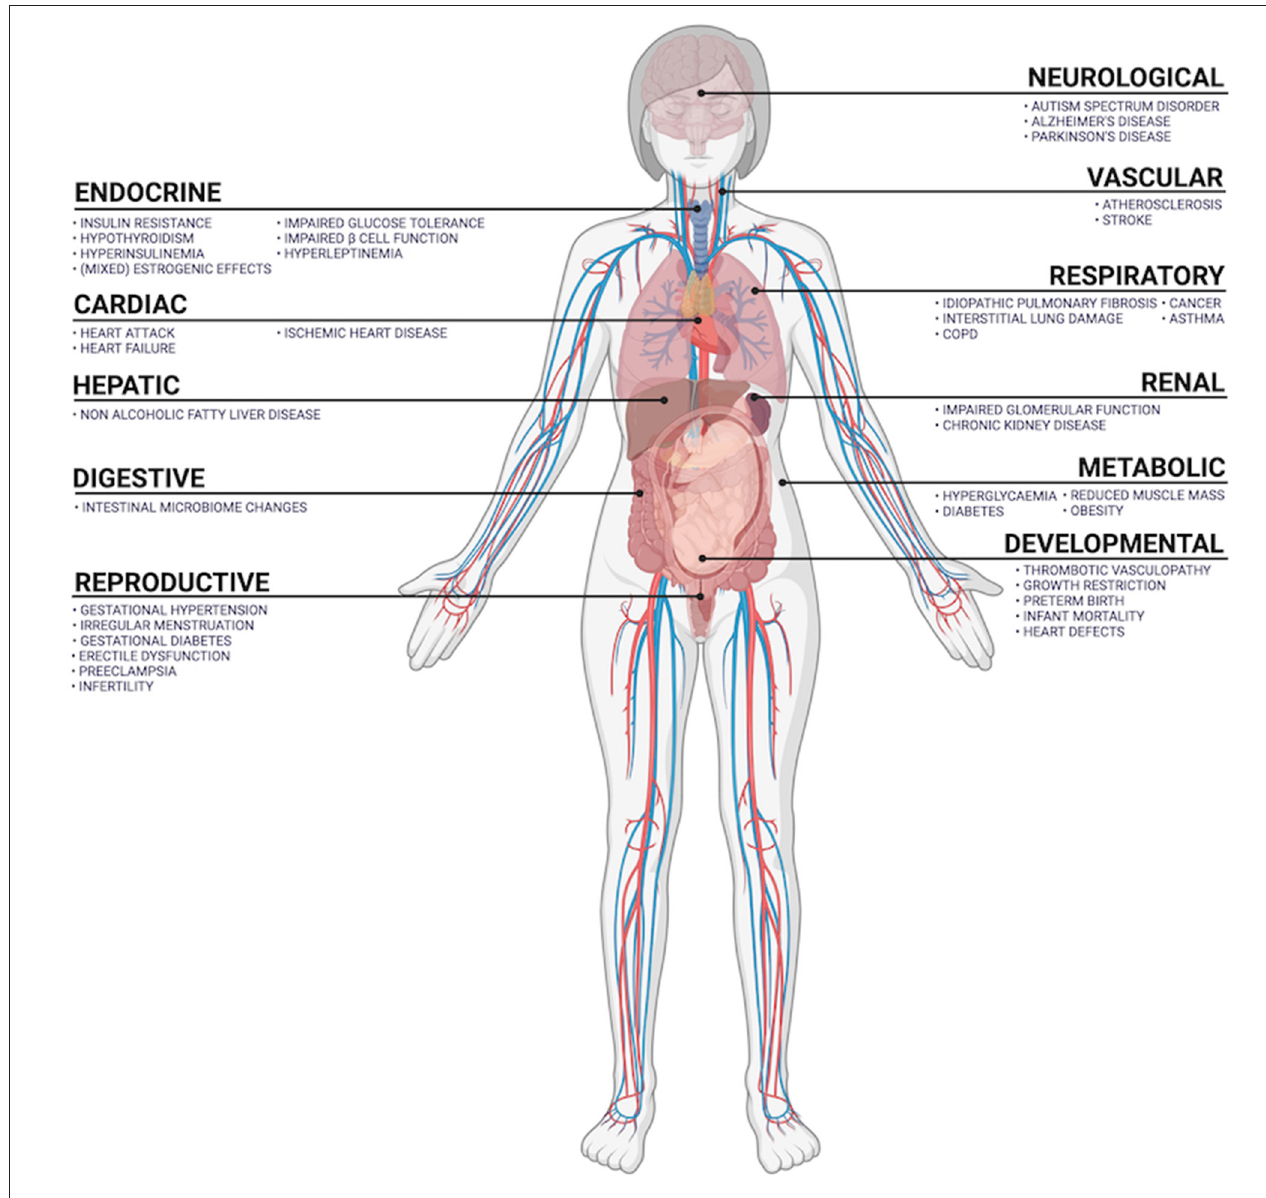
FIGURE 4 | Summary of organ systems exposed to airborne PM and diseases positively correlated with PM